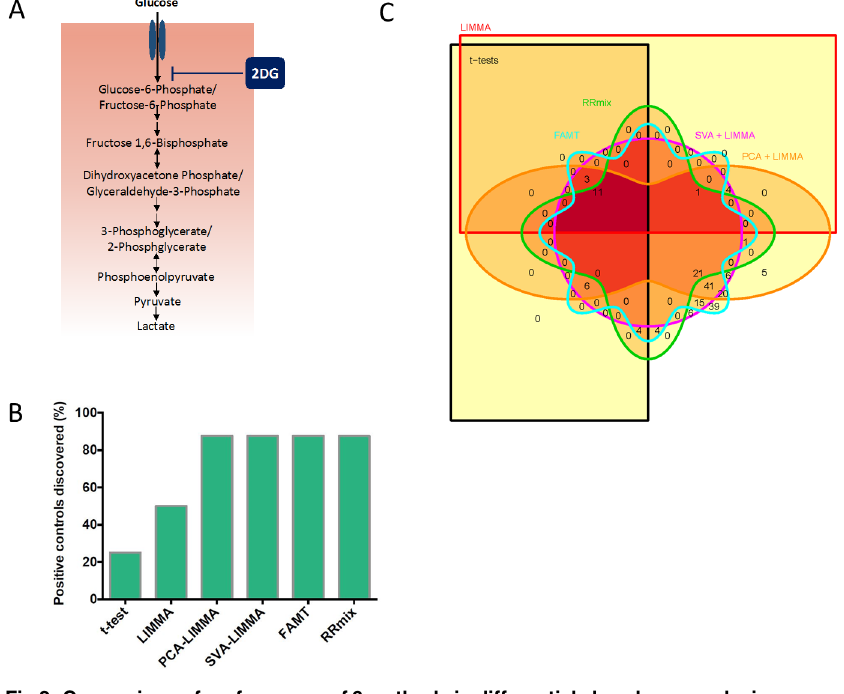
Fig 2. Comparison of performanceof 6 methods in differential abundance